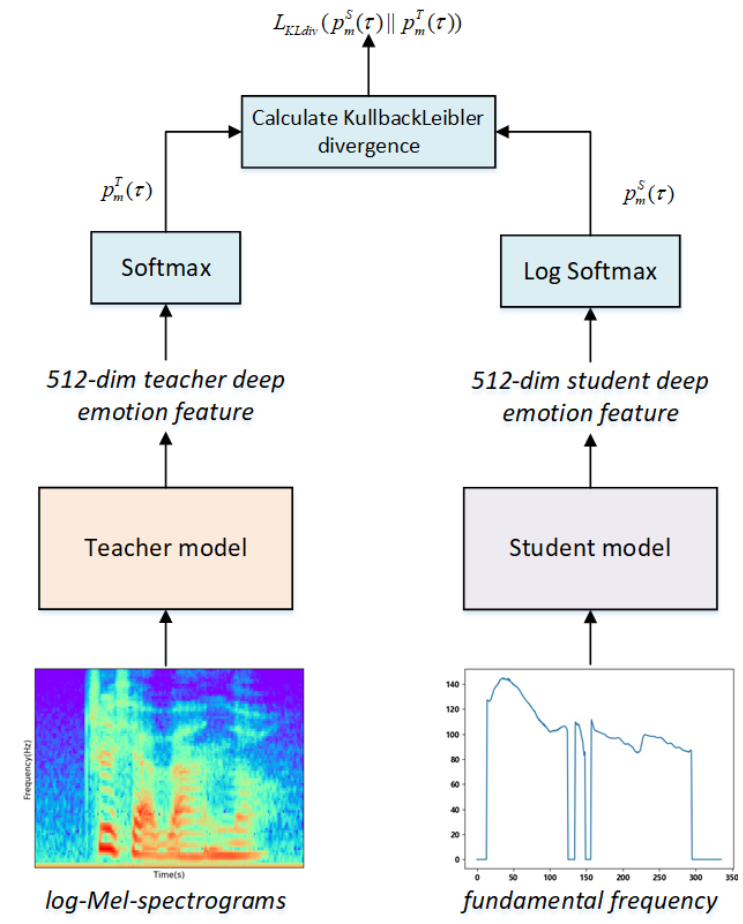
Figure 5. The procedure of cross-modal emotion